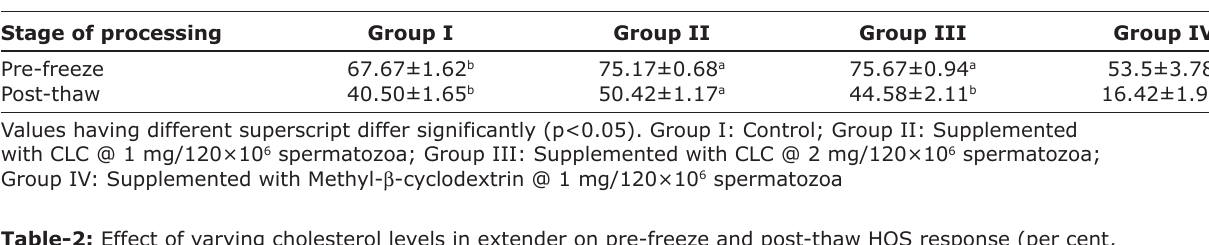
Table-2: Effect of varying cholesterol levels in extender on pre-freeze and post-thaw HOS response (per cent, mean±SEM) of Malabari buck spermatozoa (n=12). Stage of processing